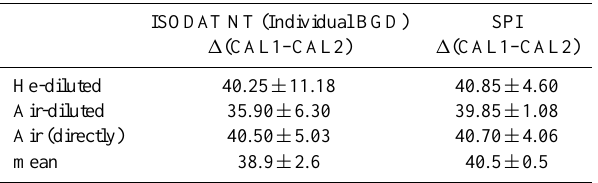
Table 4. Measured δ -difference 1 (CAL1–CAL2). The difference is measured 4‰ smaller than the nominal value of 44.4‰. This would be hardly detectable with the ISODAT evaluation, but is clearly significant with the SPI evaluation. The differences stated in the first two rows are calculated from two separate sequences com- paring a single gas to SiL, while the third row is determined from a direct comparison of CAL1 and CAL2 within a single sequence.